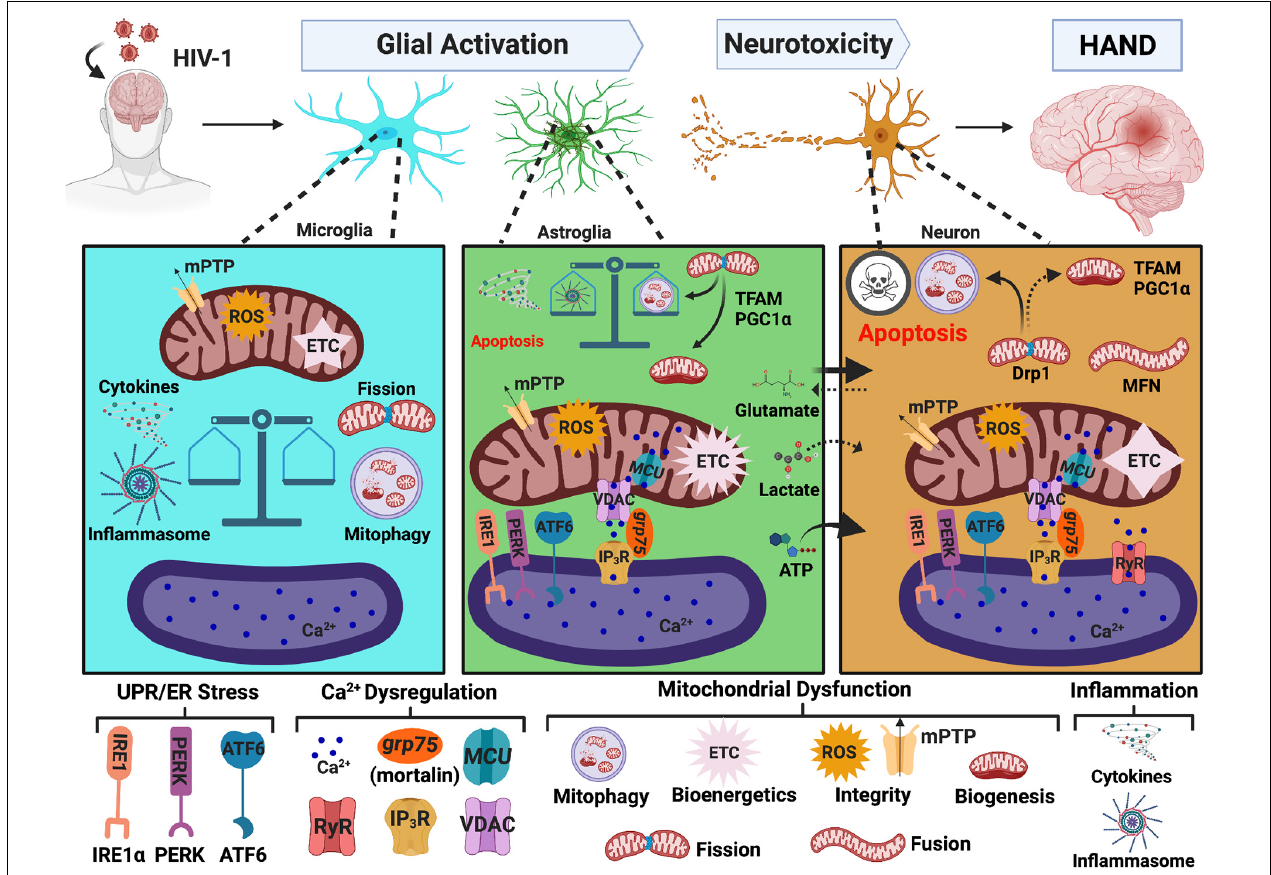
FIGURE 3 | MAMs in HAND. HIV-1 in the CNS leads to glial activation and neurotoxicity, which are key mechanisms mediating HAND pathology. HIV-induced UPR/ER stress, Ca 2 + dysregulation, and mitochondrial dysfunction strongly implicate MAMs as potential regulators of glial activation and neurotoxicity. In microglia, the initiation of mitophagy is essential to buffer HIV-induced mitochondrial dysfunction but accumulation of damaged mitochondria induces a heightened inflammatory response which is associated with impaired mitochondrial integrity and a significant decrease in bioenergetic capacity. Conversely, astrocytes increase their Ca 2 + signaling and metabolic capacity. Astrocyte shift in function leads to increased release of neurotoxic factors and well as impaired provision of essential nutrients to neurons. Similar to microglia, a balance between mitophagy and inflammasome activation appears to be a critical determinate to astrocyte fate. Notably, ER-mitochondrial Ca 2 + transfer and UPR/ER stress also arise as potential pivotal players in astrocyte-mediated neurotoxicity. While astrocytes and microglia teeter between toxic and tropic, neurons are highly vulnerable to HIV-induced mitochondrial dysfunction caused by both direct and indirect insults. Targeting MAMs to combat mitochondrial dysfunction is of heightened importance to enhance CNS fitness against neuropathologic challenges, including HIV/HAND. MAMs, mitochondria-associated ER membranes; HIV-1, human immunodeficiency virus type 1; HAND, HIV-associated neurocognitive disorders; ER, endoplasmic reticulum; UPR, unfolded protein response; PERK, protein kinase RNA-like endoplasmic reticulum kinase; IRE1, inositol-requiring protein 1 α ; ATF6, activating transcription factor 6; Ca 2 + , calcium; IP 3 R, inositol 1,4,5-triphosphate receptors; VDAC, voltage-dependent anion-selective channel; grp75, glucose-regulated protein 75 kDa; MCU, mitochondrial Ca 2 + uniporter; RyR, ryanodine receptors; MFN, mitofusin; Drp1, dynamin-related protein 1; mPTP, mitochondrial permeability transitional pore; ROS, reactive oxygen species; ETC, electron transport chain; PGC1 α , proliferator-activated receptor γ coactivator 1 α ; TFAM, transcription factor A. Image created with